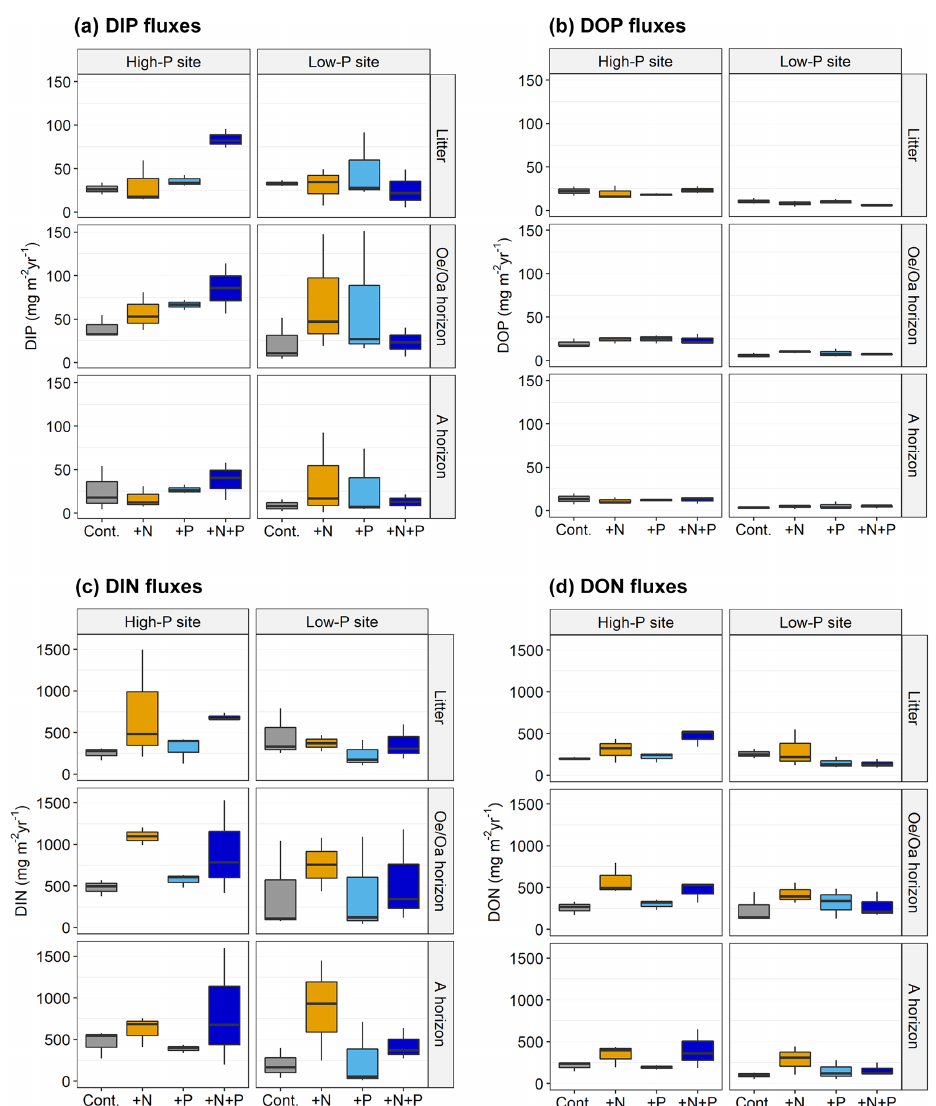
Figure 2. Estimated annual fluxes of dissolved (a) inorganic and (b) organic phosphorus (DIP and DOP), as well as of dissolved (c) inorganic and (d) organic nitrogen (DIN and DON), from in the litter horizon, the Oe / Oa horizon, and the A horizon at the high-P site and the low-P site, as affected by N addition (+N), P addition (+P), and the combined N and P addition (+N+P), as compared to the control (Cont.). The annual flux was estimated for the time period July 2018 to July 2019. Data for dissolved organic carbon can be found in Sect.